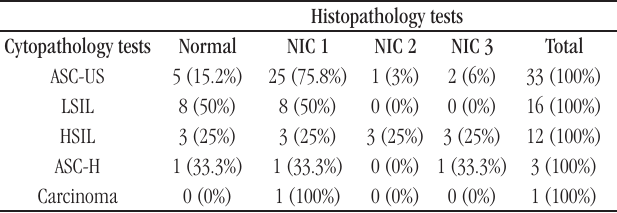
Histopathology tests